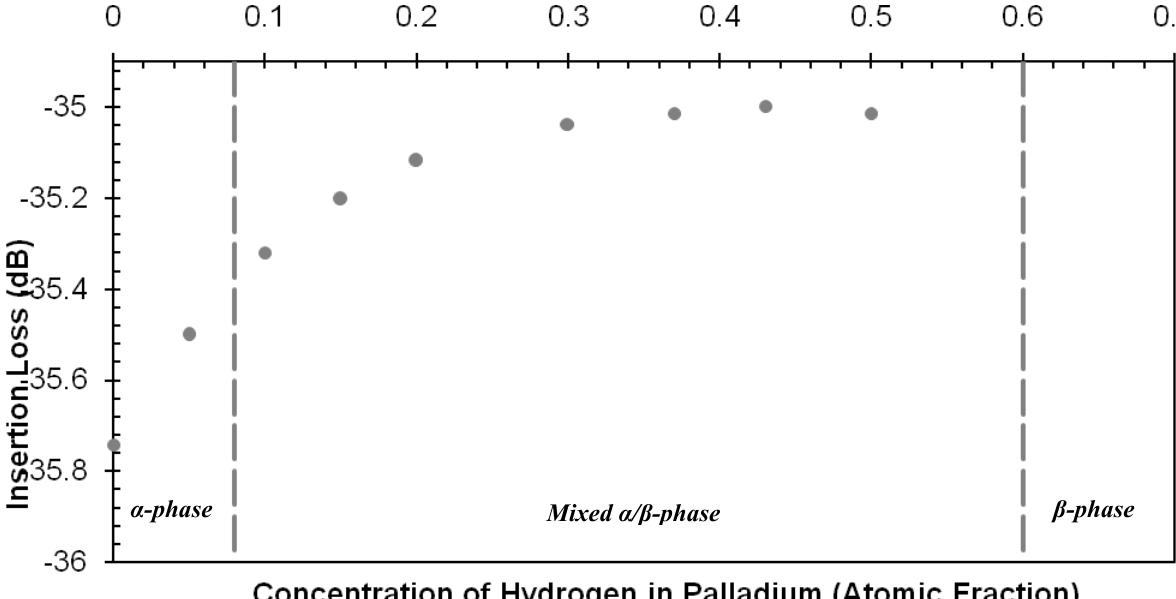
Figure 10. Insertion loss values at different levels of hydrogen concentrations.